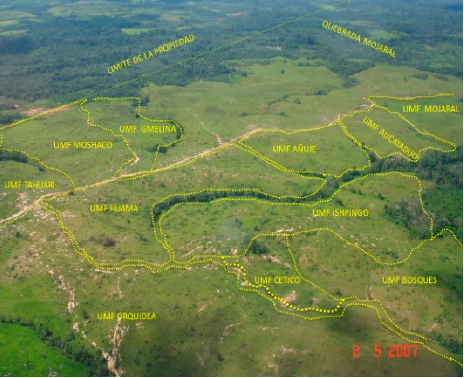
Figure 8. Delimitation of the project area in management units.